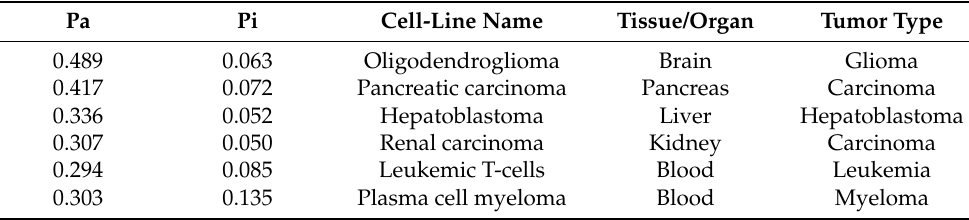
Table 1. Cancer cell line prediction results for the ligand. Pa (probability “to be active”); Pi (probability “to be inactive”).